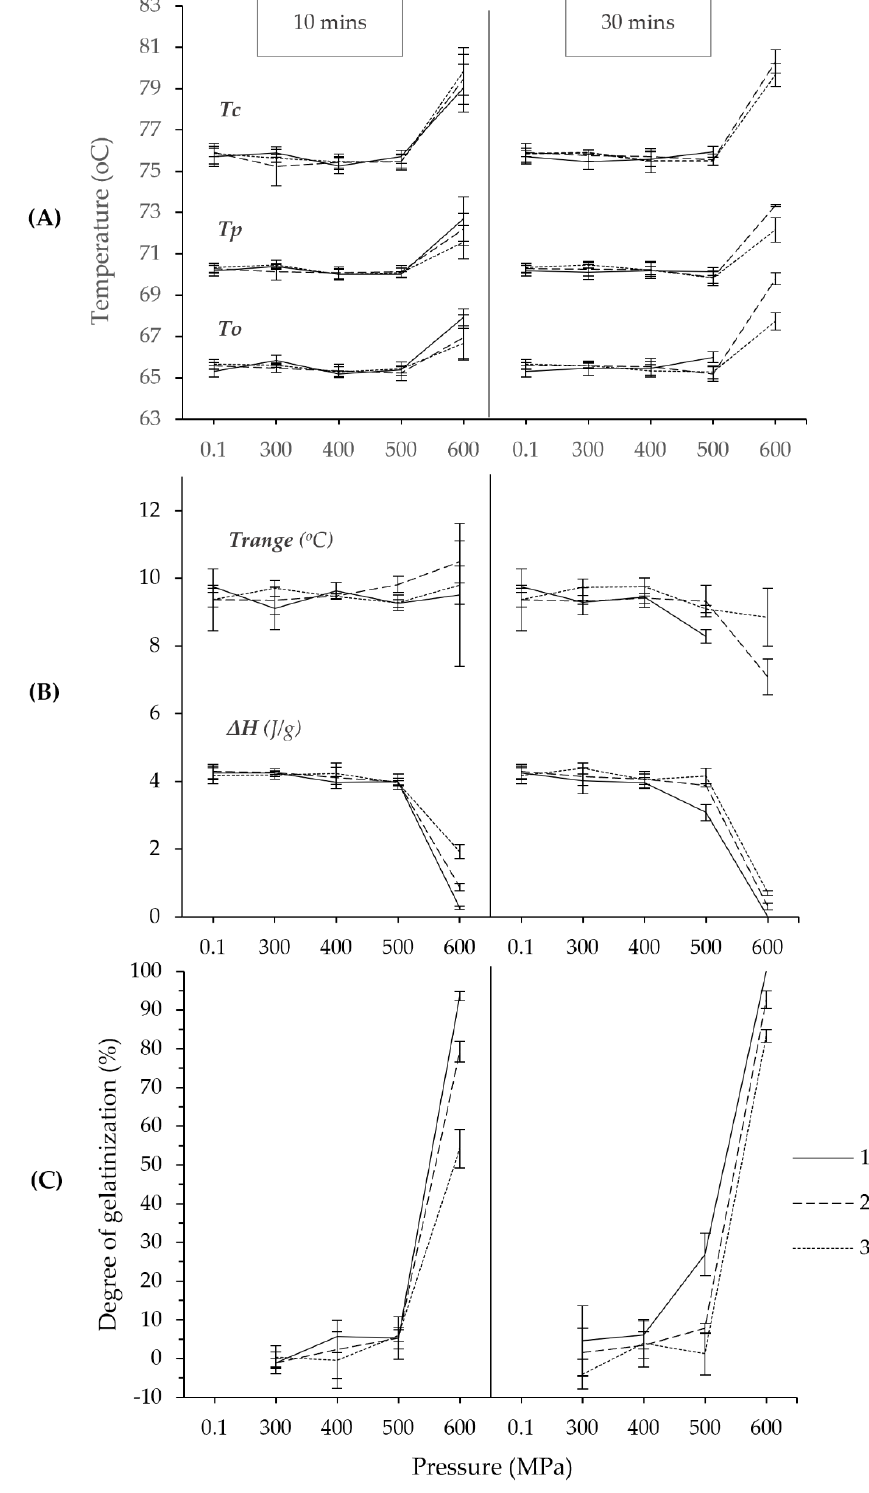
Figure 6. The thermal properties of untreated and HPP-treated cassava flour. ( A ) onset ( To ), peak ( Tp ), conclusion, and ( Tc ) gelatinization temperatures; ( B ) temperature range of gelatinization ( Trange ) and gelatinization enthalpy (Δ H ); ( C ) degree of gelatinization. Error bars represent ± standard deviation (n = 3).